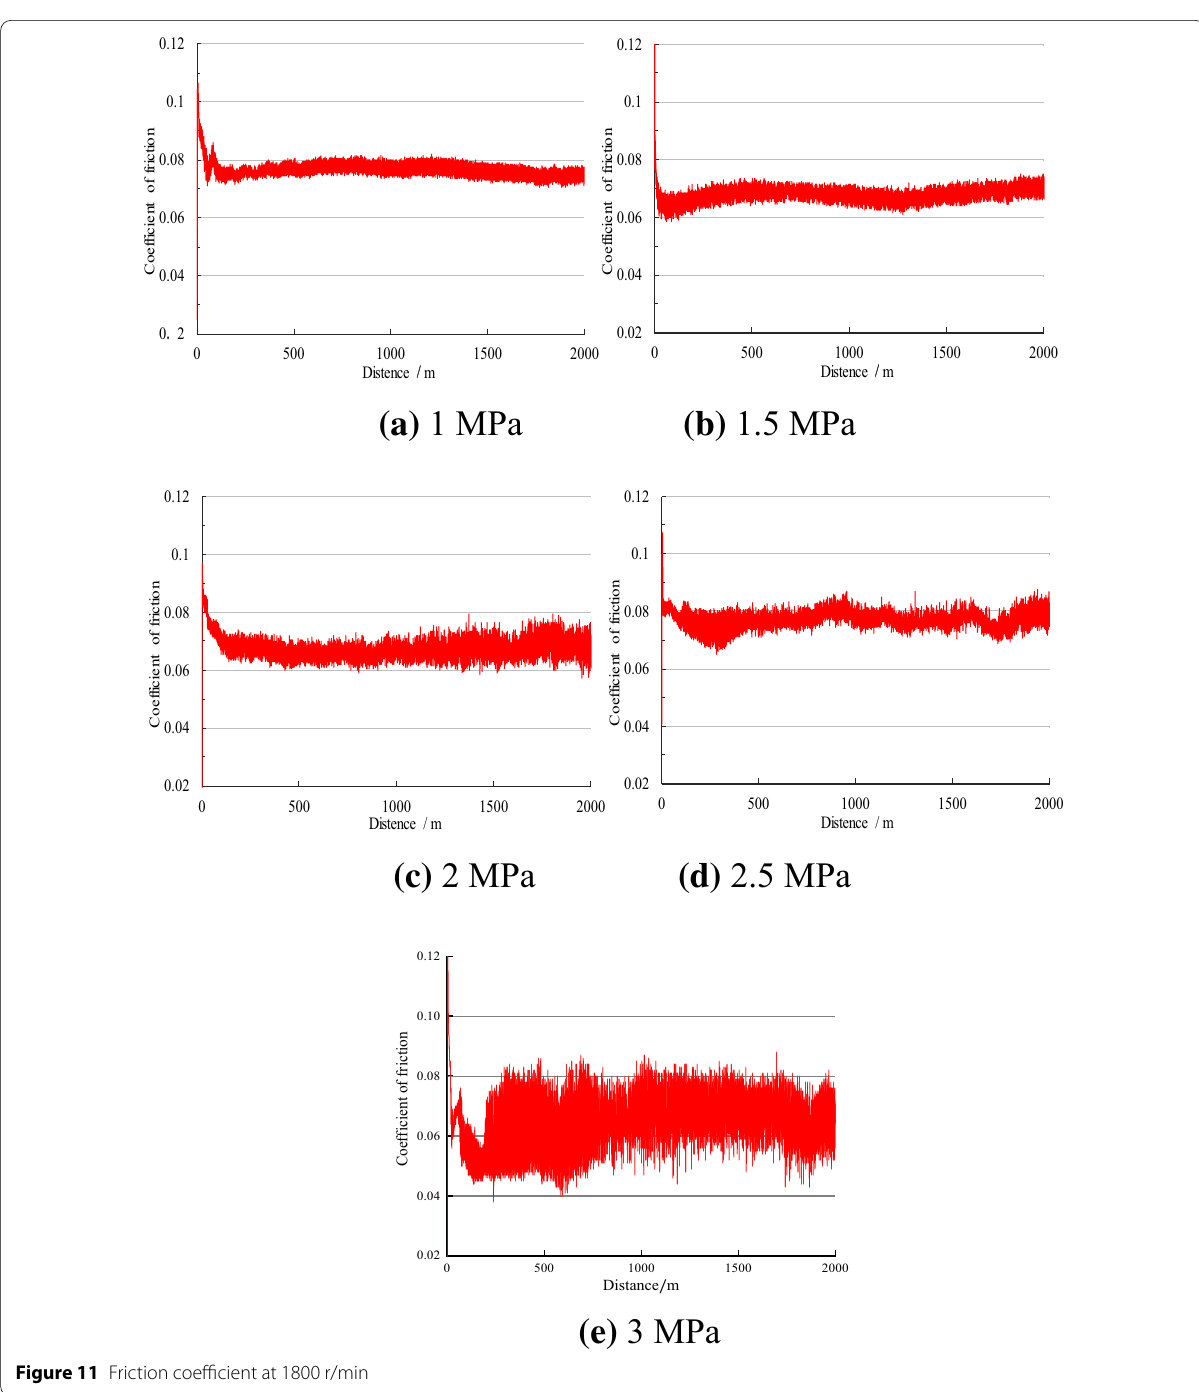
Figure 11 Friction coefficient at 1800